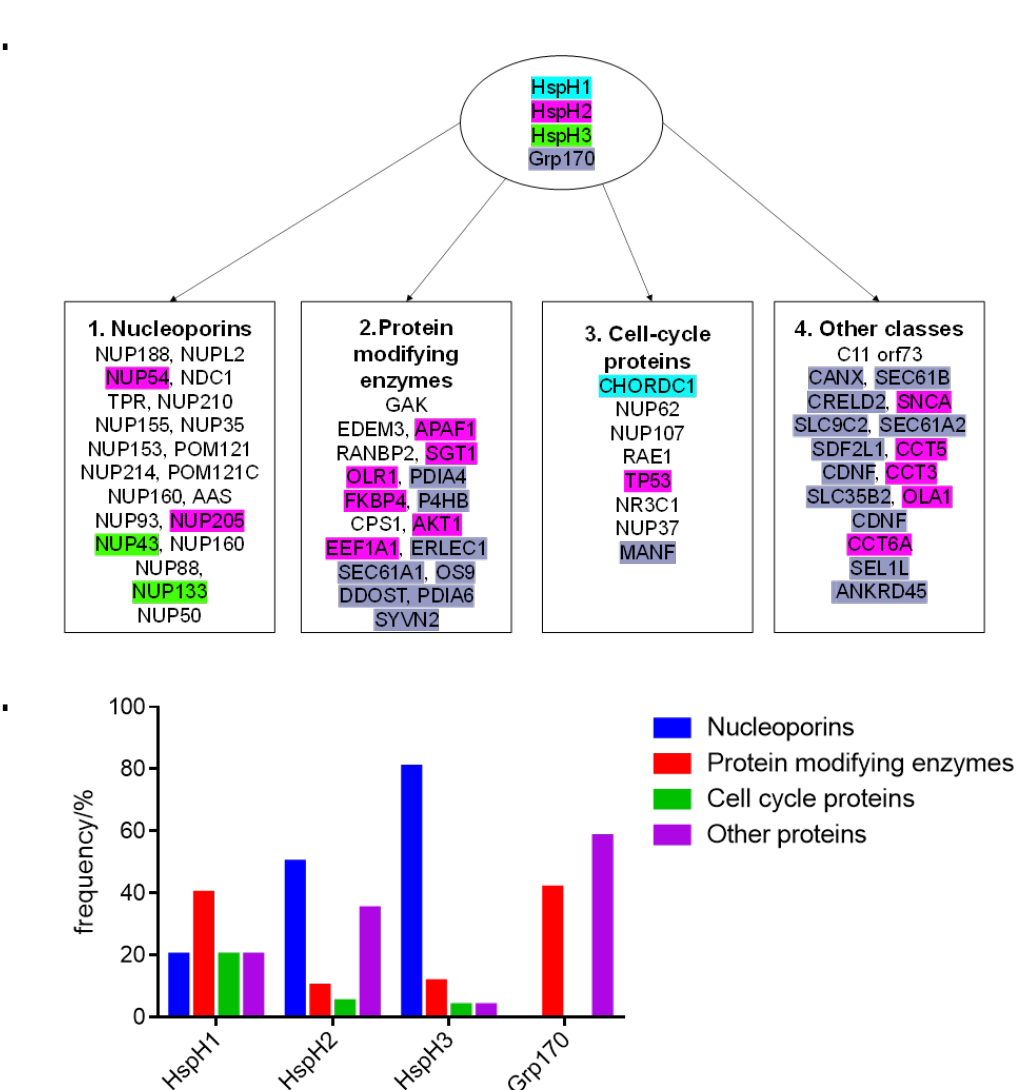
Figure 4. Predicted clients of Hsp110 and Grp170 members: ( A ) The predicted clientele of HSP110 and Grp170 are shown. Client proteins that are unique to each Hsp110/Grp170 type are shown highlighted in blue (HspH1), purple (HspH2), green (HspH3) and green (Grp170). Client proteins that are shared by more than one Hsp110/Grp170 type are not highlighted. Predictions were conducted using STRING database at a cut off score of 0.75. ( B ) Bar graph showing relative frequencies of clients of Hsp110 and Grp170 chaperones. While HspH1, HspH2 and HspH3 are generally predicted to associate with nucleoporins and cell-cycle regulating proteins, Grp170 interacts with a large complement of protein modifying enzymes and proteins involved in other functions such as translocation.